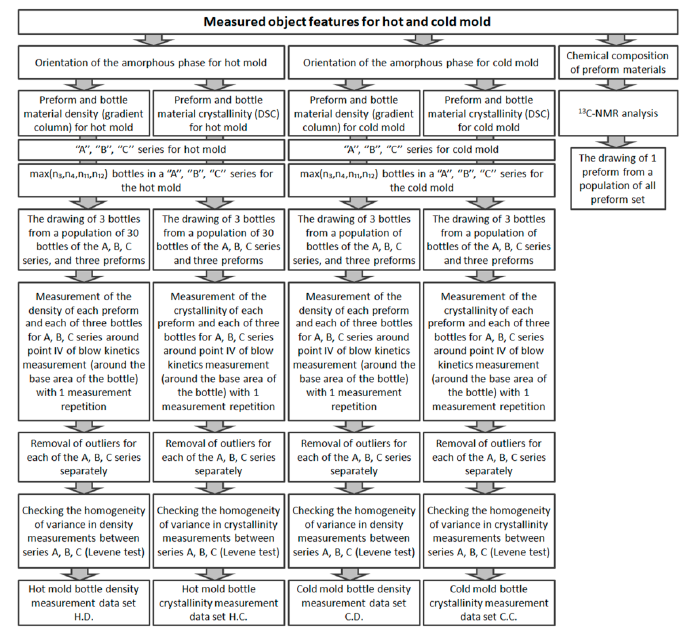
Figure A3. The method of statistical preparation of a set of measurement data for the degree of crystallinity by the DSC method (H.C.) and density in the gradient column (H.D.) of hot fill bottles and the degree of crystallinity by the DSC method (C.C.) and density in the gradient column (C.D.) of cold fill bottles, respectively.